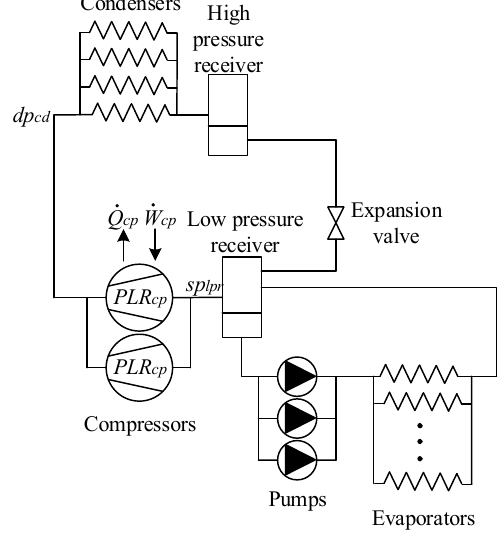
Figure 1. Refrigeration system scheme.